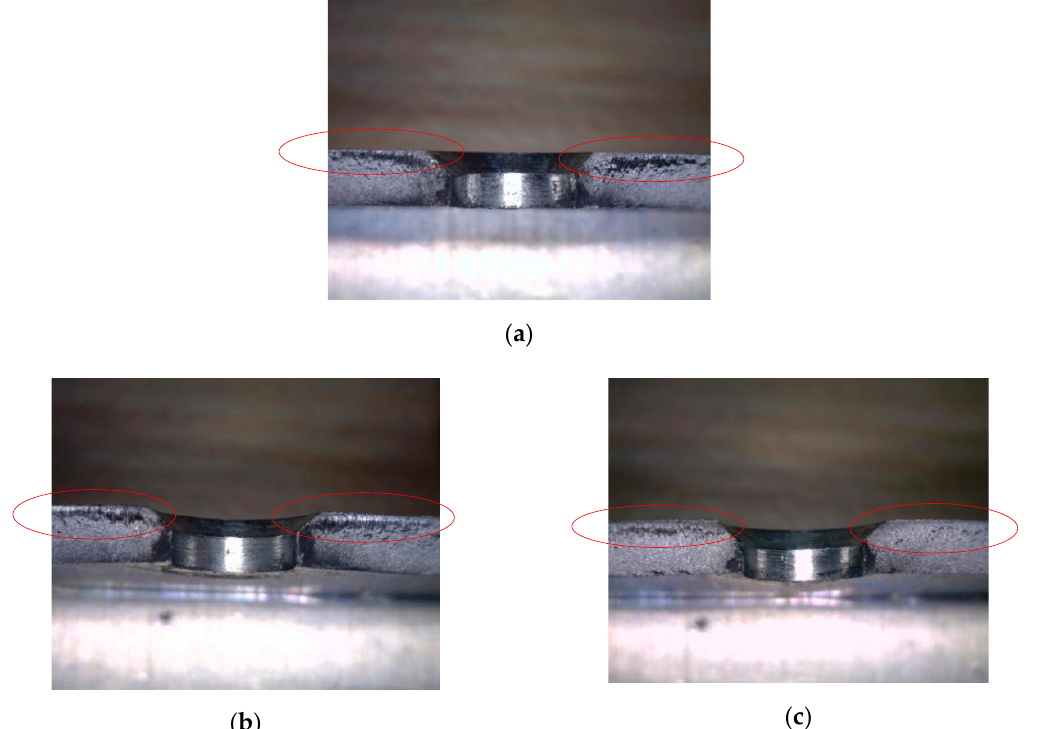
Figure 16. Fatigue fracture section of riveted lap joint: ( a ) fatigue fracture section of 0° standard part (0-0); ( b ) fatigue fracture section of riveted lap joint with 1° in the 0° direction (0-1); ( c ) fatigue fracture section of riveted lap joint with 1° in the 180° direction (180-1).